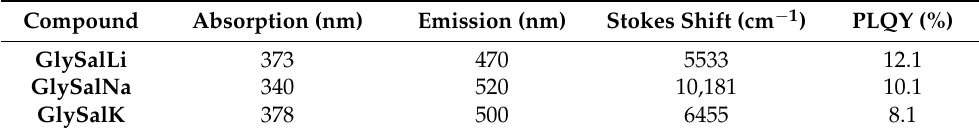
Table 4. Photophysical data of GlySalX in the solid state.